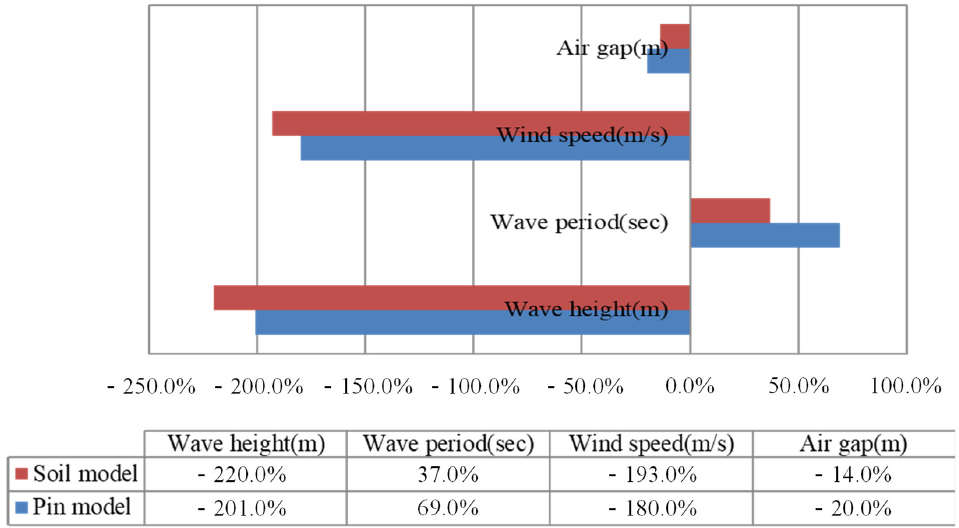
Figure 14. Summary on effect of overturning stability response according to parameters .